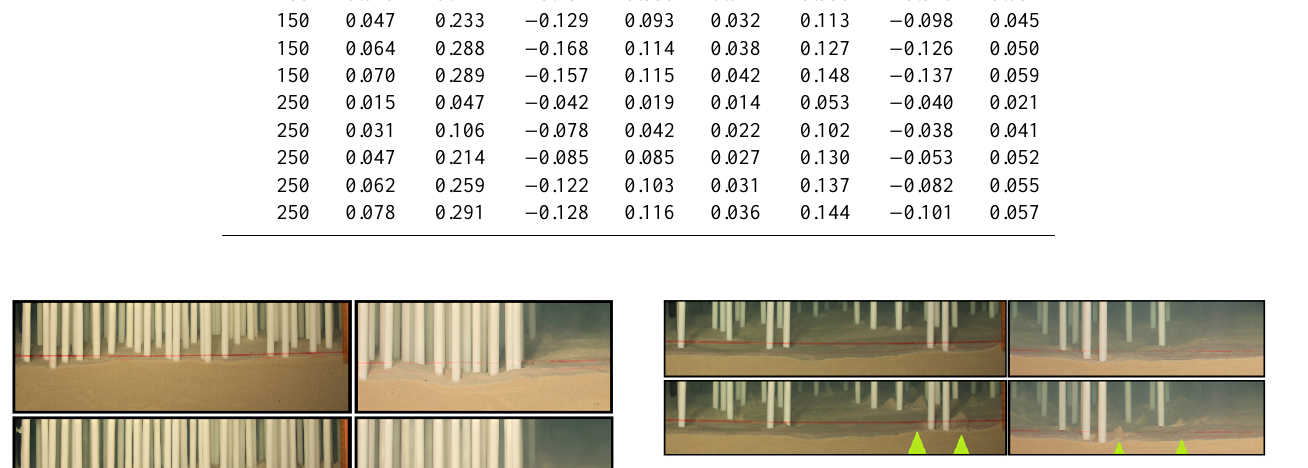
Figure 4. Side view: n = 25m − 2 , upstream (left) and downstream (right) edge of the array, before (up) and after (down) 5min running at f p = 30Hz. Notice the scour and bedforms forming within the array at the up- and downstream sections (as pointed by the green arrows). Red line is the initial reference for the bed level. Notice the factor of 2 increase in the vertical